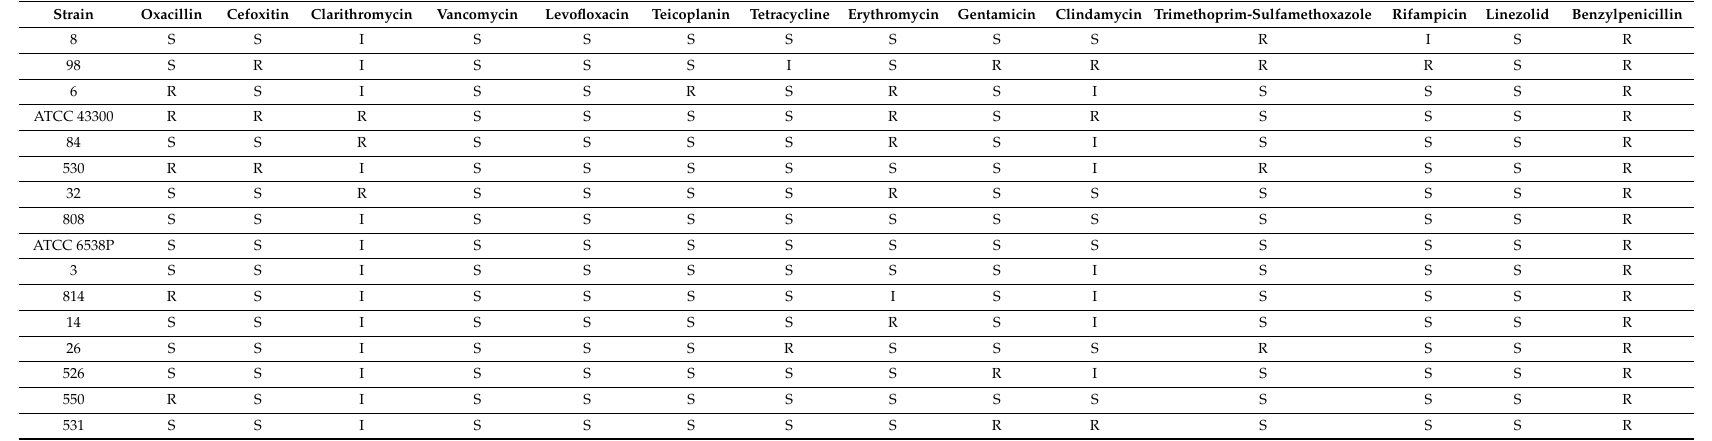
Table 3. Strains classification into “susceptible standard dosing regimen” (S), “susceptible increased exposure” (I), and “resistant” (R) to the selected antibiotics. Values represent the mean of three determinations ± SD. R indicates